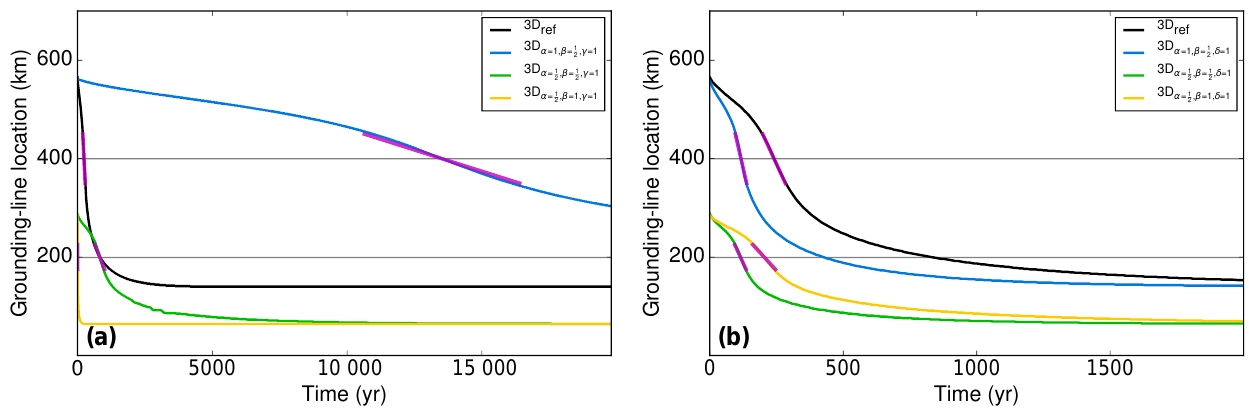
Figure 6. Time series of centerline grounding-line position (along y = 0) for the reference and three geometrically scaled 3-D channel experiments with (a) identical basal friction and (b) identical surface mass balance, respectively. The fitting method is the same as described in Fig. 5 with a reference retreat rate of 1.18kmyr − 1